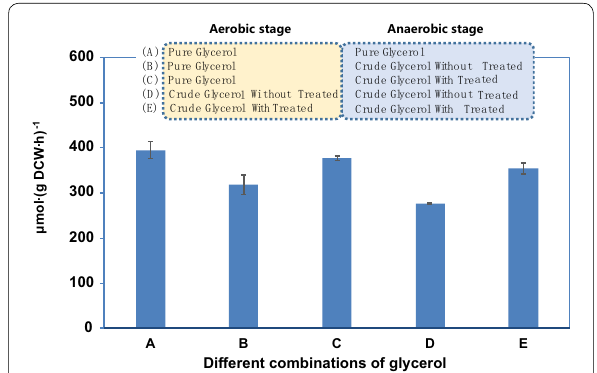
ND Not detected Data are means standard deviations with three replicates ±